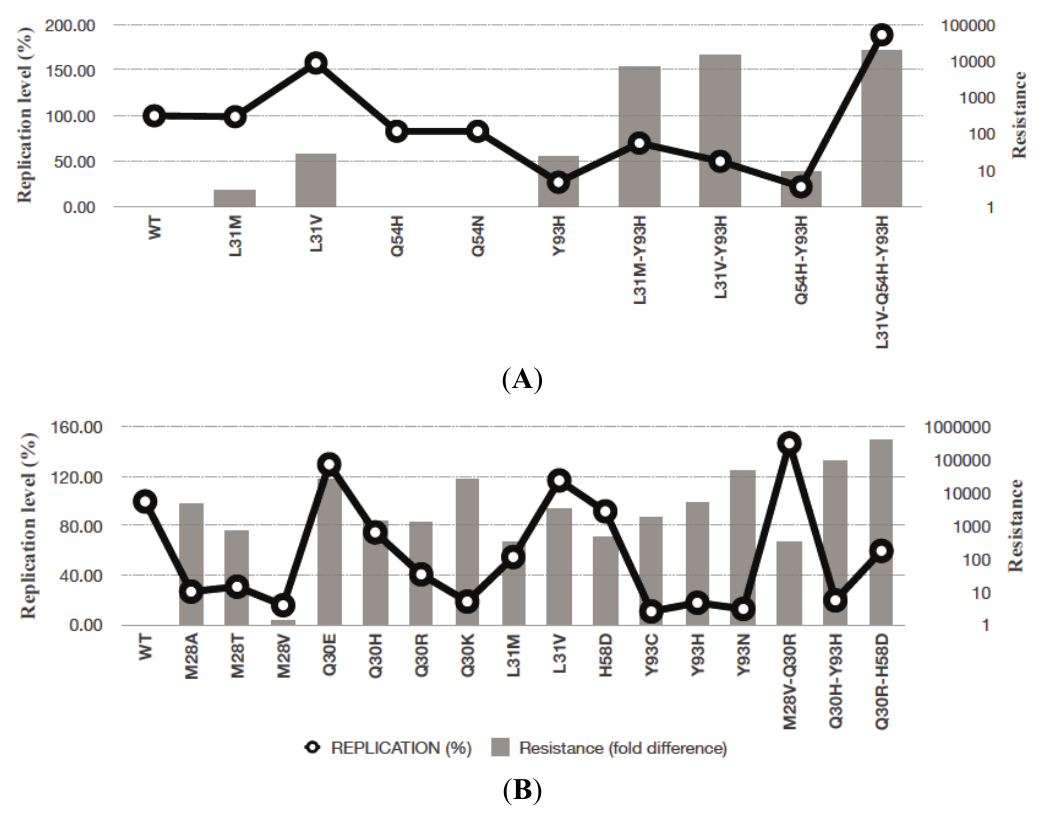
Figure 1. Fitness and level of resistance of DCV-associated mutations assessed against HCV genotype 1a ( A ) and 1b ( B ) replicons. The bar chart represents the fold decrease in drug susceptibility of HCV variants compared with WT. Open circles show differences in replication capacity, respectively. The figure is adapted from Fridell and colleagues